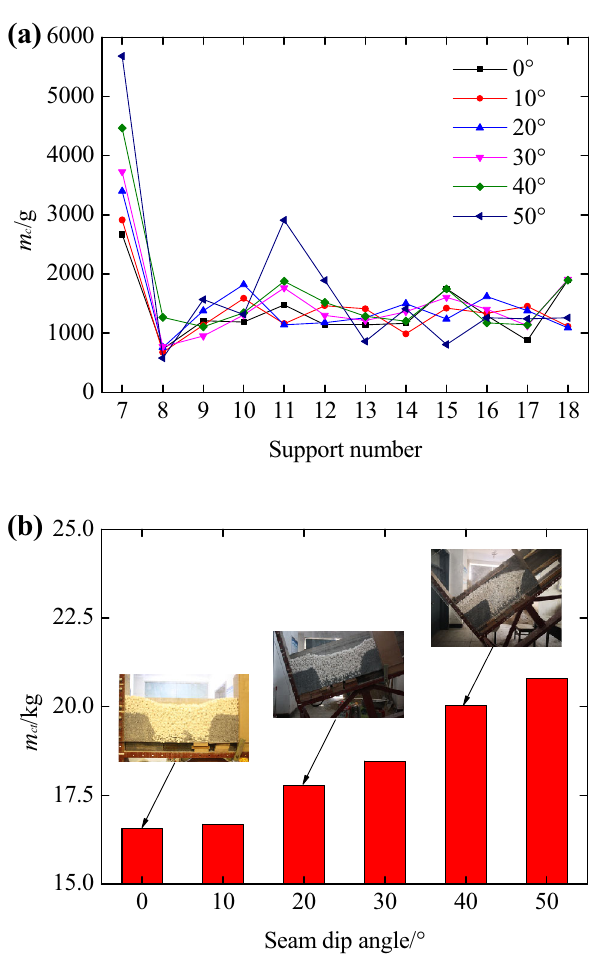
Fig. 3 a Variation of mass of drawn top coal with support number; b variation of total mass of drawn top coal with seam dip